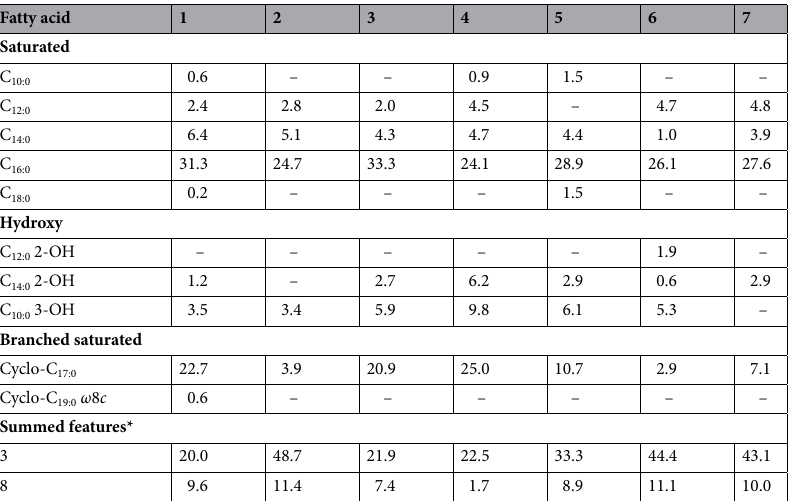
Table 4. Cellular fatty acid profiles (percentage of totals) of TW-1 T and phylogenetically related reference strains of the genus Massilia . Strains: 1, TW-1 T ; 2, M. pinisoli KACC 18748 T ; 3, M. putida KACC 21418 T ; 4, M. phosphatilytica KACC 21417 T ; 5, M. arvi KACC 21416 T ; 6, M. niastensis KACC 12599 T ; 7, M. kyonggiensis KACC 17471 T . All data were obtained from this study. Fatty acid amounting < 0.5% in all strains are not listed. –, not detected. *Summed features represent groups of two or three fatty acids that could not be separated using the MIDI system. Summed feature 3 comprised iso-C 15 :0 2-OH/C 16 :1 ω 7 c and summed feature 8 comprised C 18:1 ω 6 c and/or C 18 :1 ω 7 c